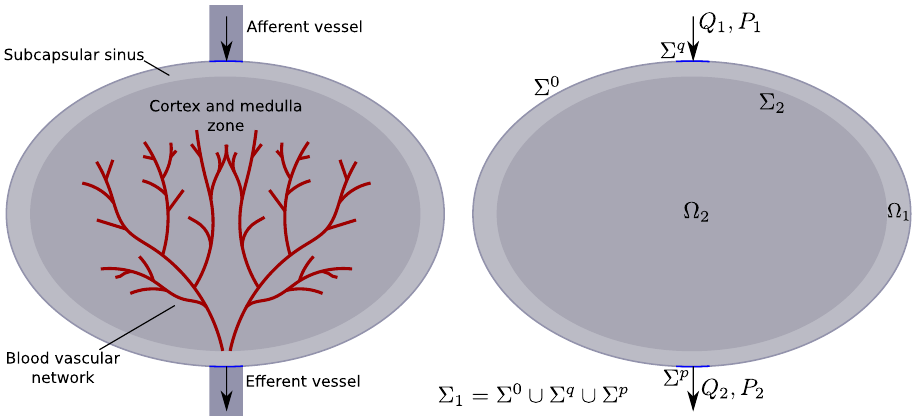
Figure 1. Simplified 3D view of a lymph node. Biological components of an idealized LN ( left ). Components of the geometry model ( right ): external domain Ω 1 containing porous media with higher hydraulic conductivity and internal domain with lower hydraulic conductivity Ω 2 where the exchange of lymph with CS takes